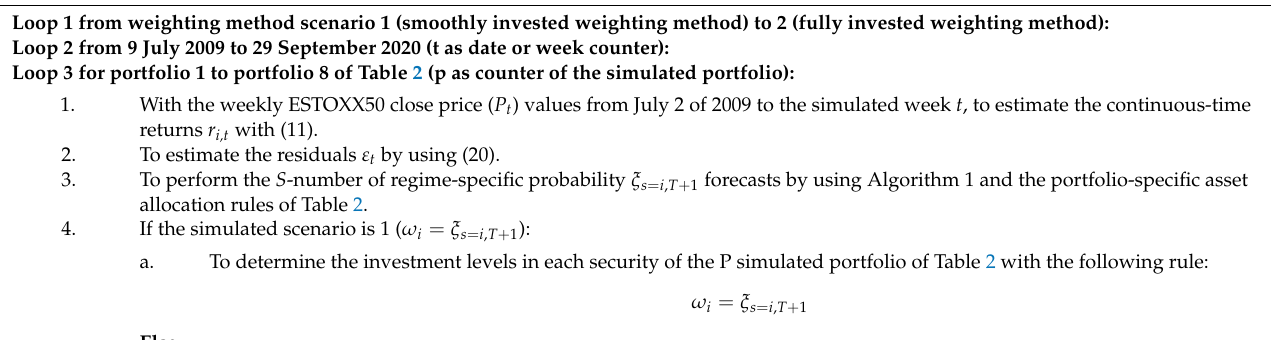
Algorithm 2 The steps followed in the simulation of the three theoretical investors that invest in the eight theoretical portfolios (asset allocation rules) of Table 2. Loop 1 from weighting method scenario 1 (smoothly invested weighting method) to 2 (fully invested weighting method): Loop 2 from 9 July 2009 to 29 September 2020 (t as date or week counter): Loop 3 for portfolio 1 to portfolio 8 of Table 2 (p as counter of the simulated